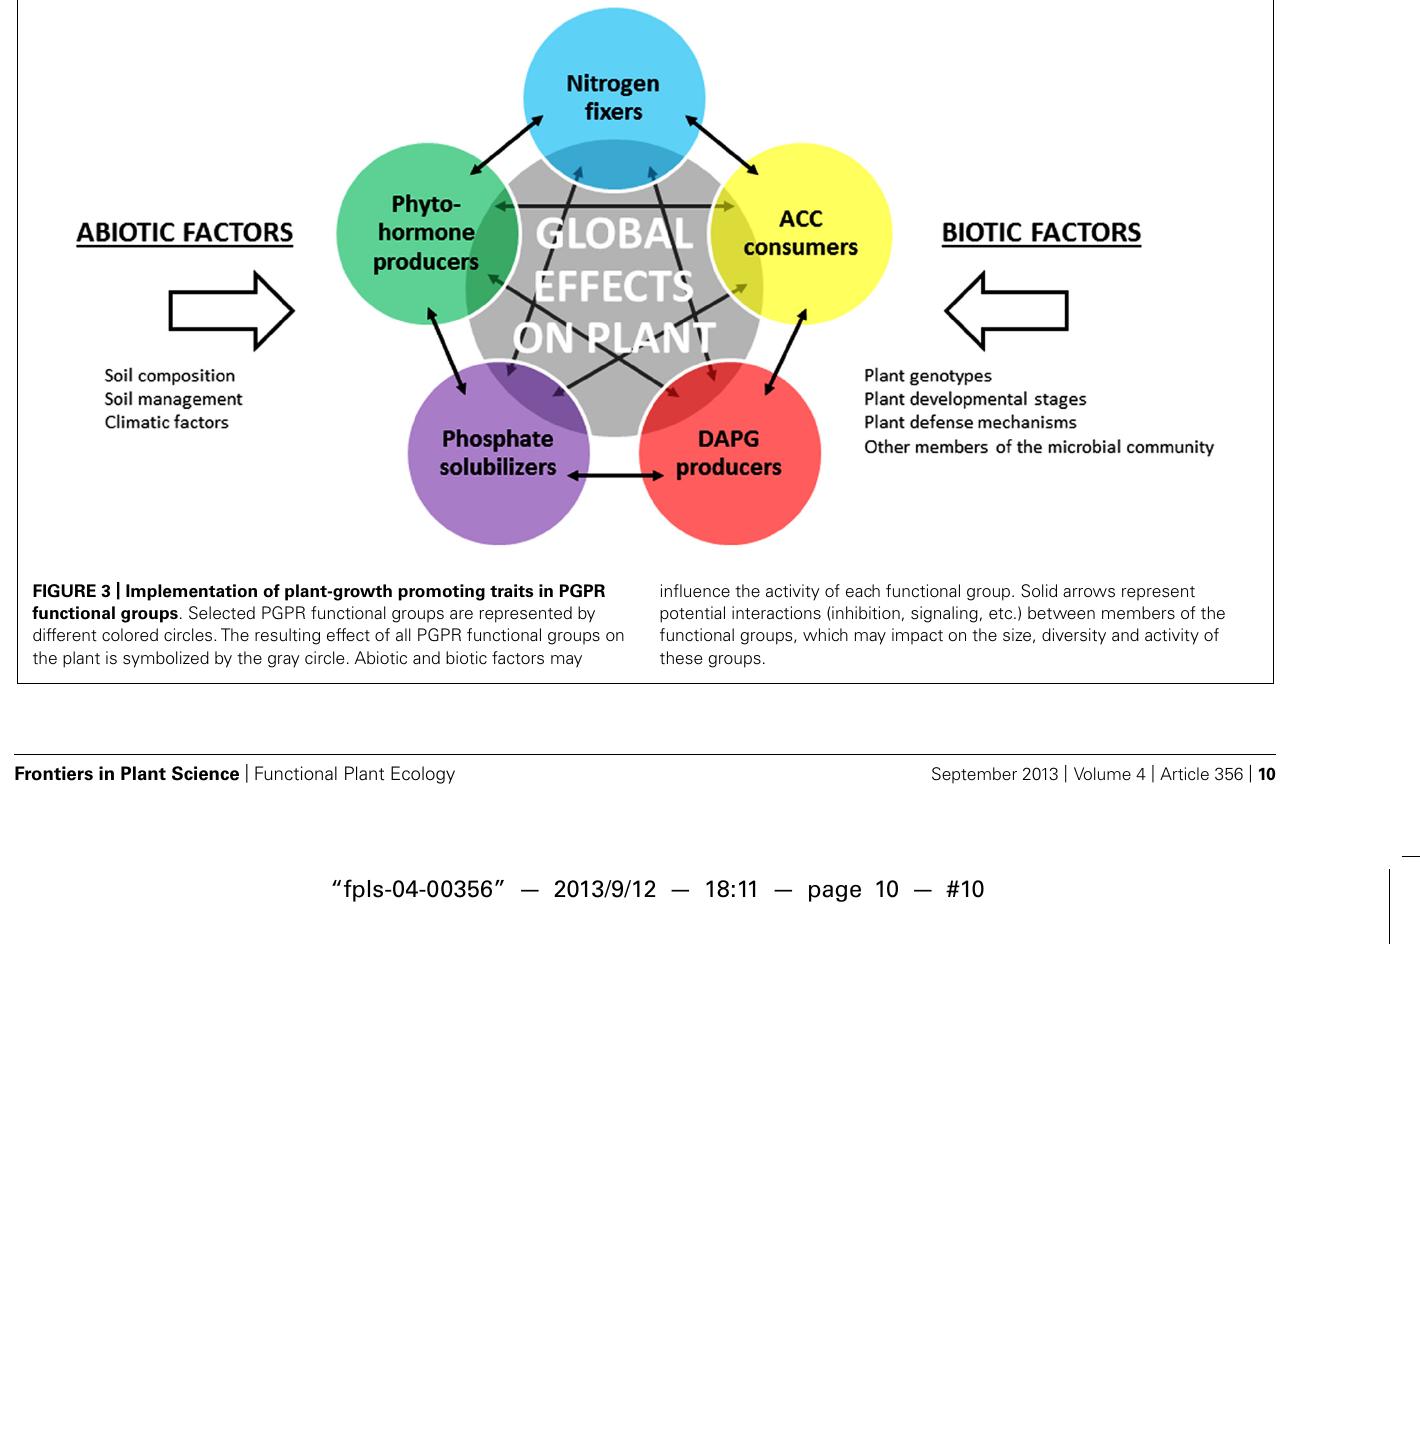
influence the activity of each functional group. Solid arrows represent potential interactions (inhibition, signaling, etc.) between members of the functional groups, which may impact on the size, diversity and activity of these